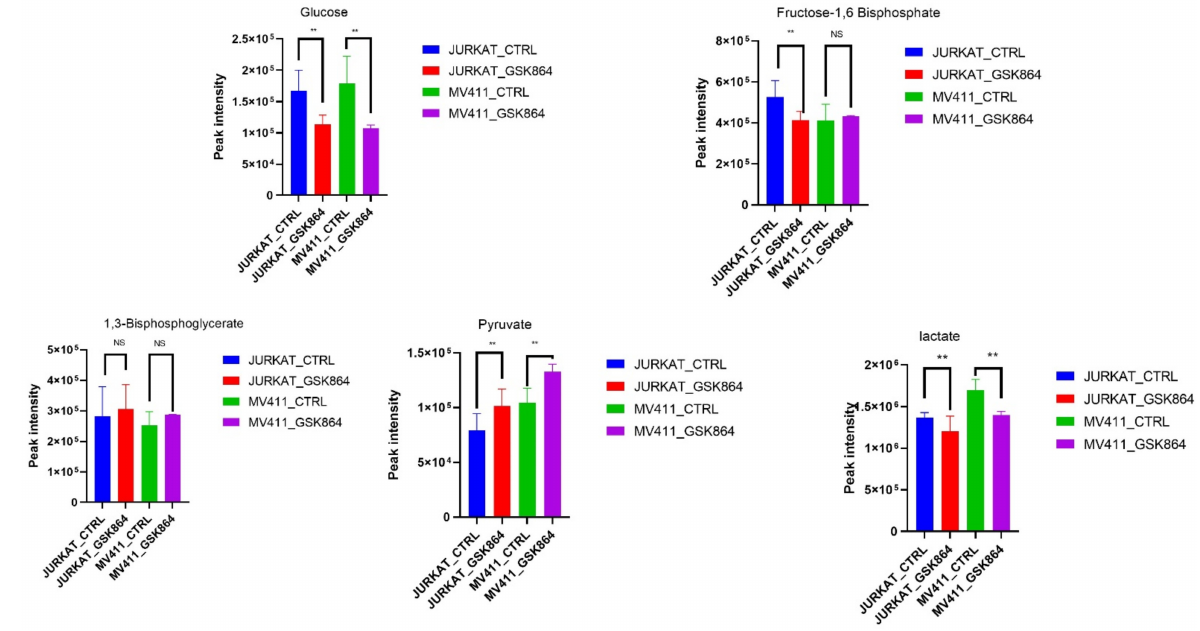
Figure 3. IDHi altered crucial cellular energy pathways in leukemic cells. Quantitative levels of various metabolites involved in glycolysis pathways of control and GSK864-treated cells; ** p < 0.00. IDHi displayed enrichment of metabolites related to the TCA cycle, OXPHOS interme- diates. However, some TCA cycle metabolites, including fumarate, citrate, α -ketoglutarate, acetoacetate, glutamate, oxaloacetate, and pyruvate, were reduced in IDHi (Figure 4). These results suggest that the leukemic cells switched to a more glycolytic phenotype from an oxidative phosphorylation (OXPHOS) phenotype and were regulated by IDHi (Figure 4).